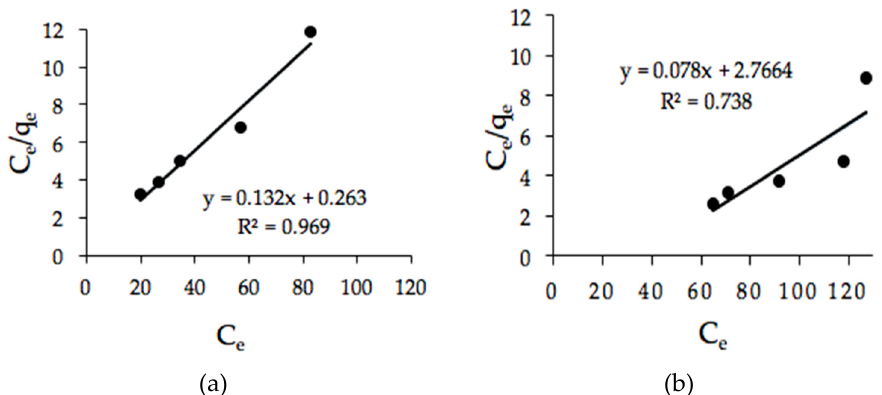
Figure 9. Langmuir isotherm plot adsorption using POMB-retained ash: ( a ) microwave irradiated and ( b ) H 2 SO 4 –microwave irradiated. Table 7. Freundlich adsorption isotherm analysis.